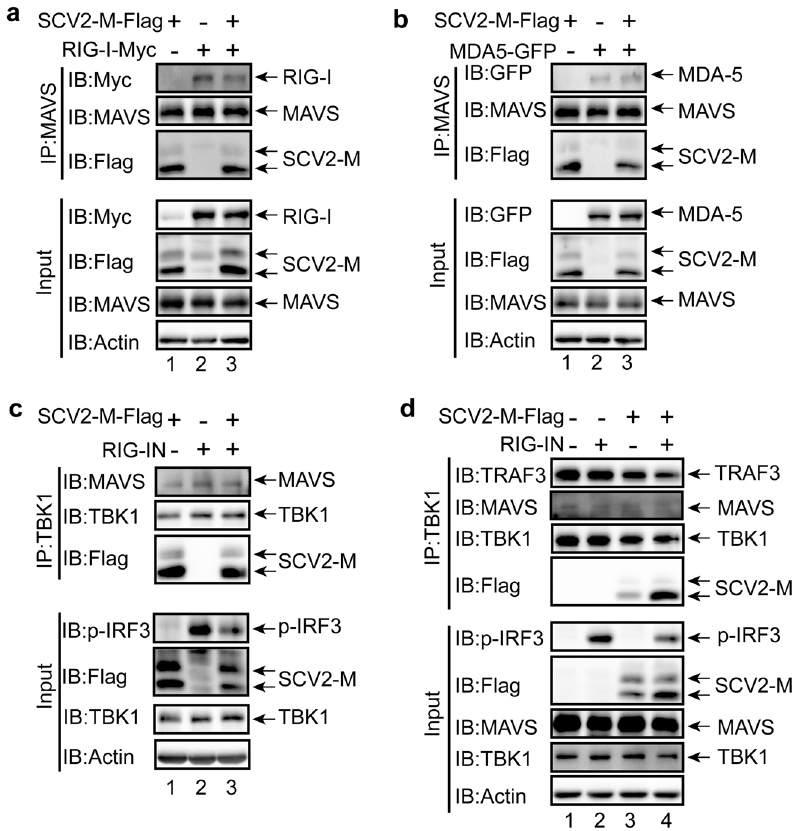
Fig. 5 The SARS-CoV-2 M protein prevents the formation of the RIG-I – MAVS – TRAF3 – TBK1 multiprotein complex. The SARS-CoV-2 M protein inhibits the RIG-I – MAVS ( a ), MAVS – TBK1 ( c ), and TRAF3 – TBK1 ( d ) but not MDA-5 – MAVS ( b ) interactions. The HEK293T cells were transfected with the indicated plasmids for 24 h before coimmunoprecipitation with the antibodies against MAVS ( a and b ) or TBK1 ( c and d ). The pcDNA6B empty vector was used to balance the total amount of plasmid DNA in the transfection. The input and immunoprecipitates were immunoblotted with the indicated antibodies. Immunoblotting results are representative of two independent experiments. SARS-CoV-2 M protein,